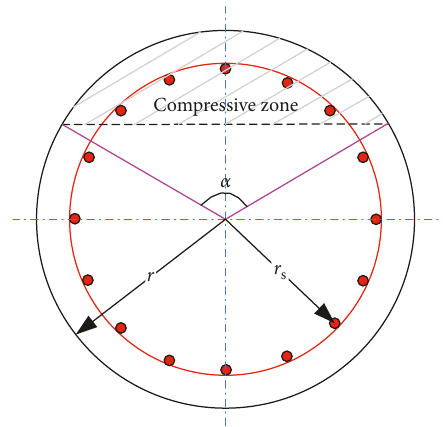
Figure 3: Circular section with uniformly circumferentially dis- tributed